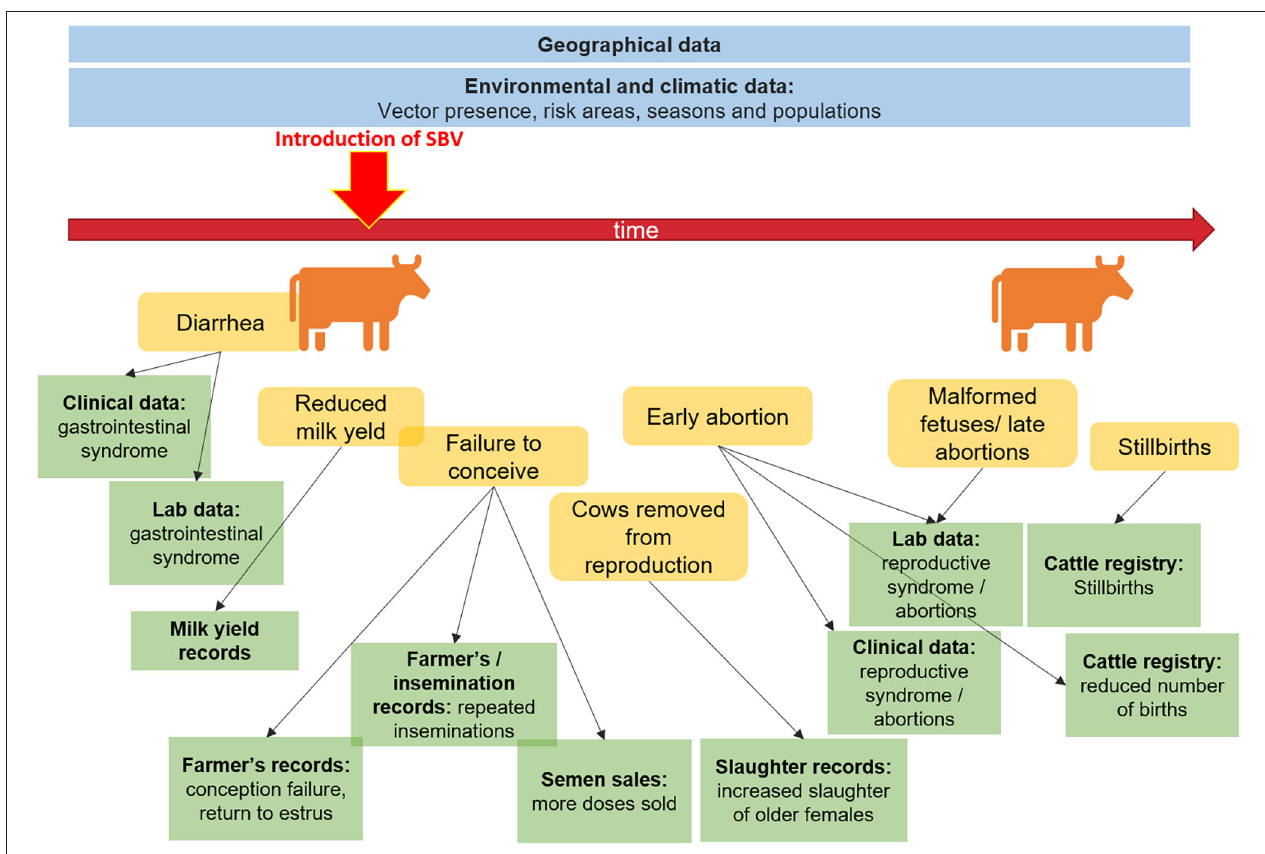
FIGURE 1 | Potential data sources to aid surveillance before and after the introduction of Schmallenberg